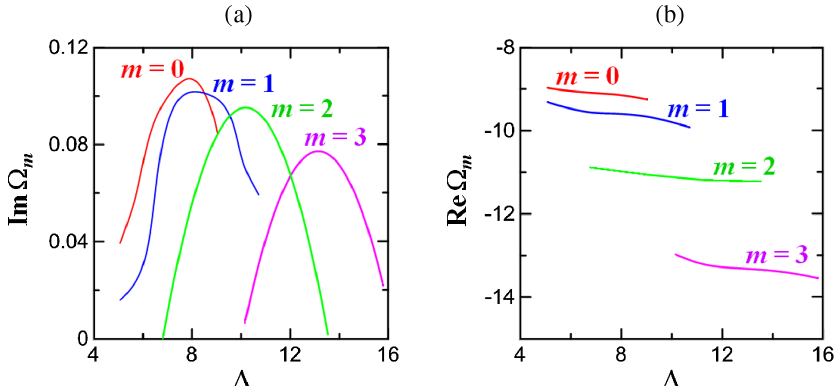
FIG. 4. Temporal increments Im Ω (a) and eigenfrequencies Re Ω m α ¼ 2 . 2 , L 1 . 5 , L 1 . 9 , B 0 . 2 z ¼ x ¼ e ¼